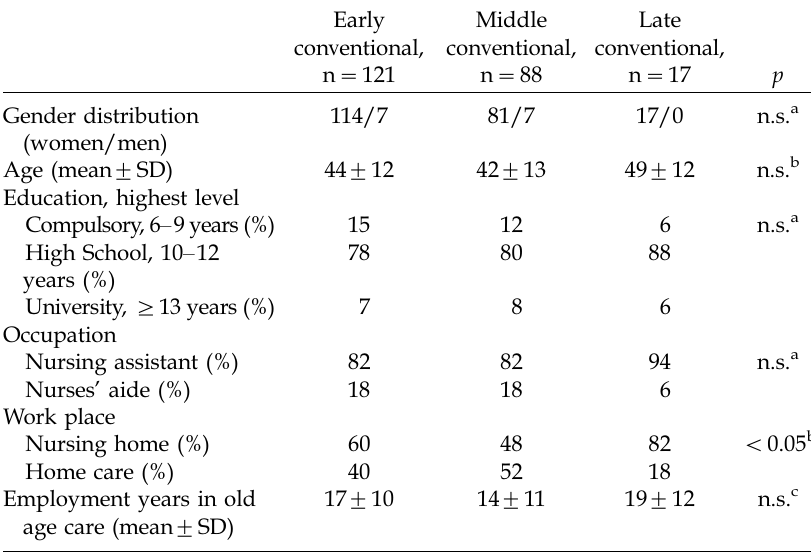
Table 2. Socio-demographic and occupational characteristics of the three sub-groups with different v alue